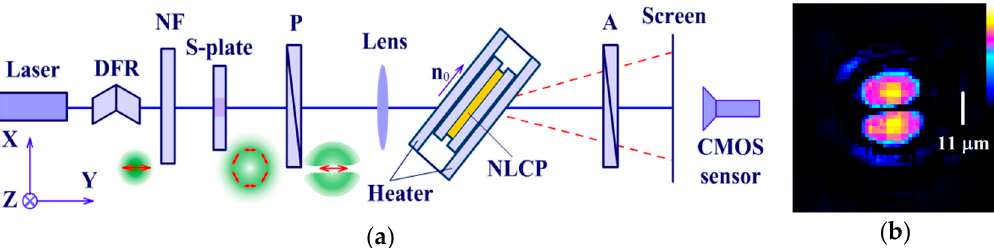
Figure 1. ( a ) Schematic of the experimental setup (top view): (DFR) double Fresnel rhomb, (NF) neutral density filter, (P) polarizer, (A) analyzer–polarizer. The vector n 0 is the unperturbed director. S-waveplate is oriented to produce azimuthal polarization. Red double arrows indicate the polarization direction. ( b ) Color map of the beam intensity distribution in the focal plane. White bar indicates the distance d between intensity peaks.